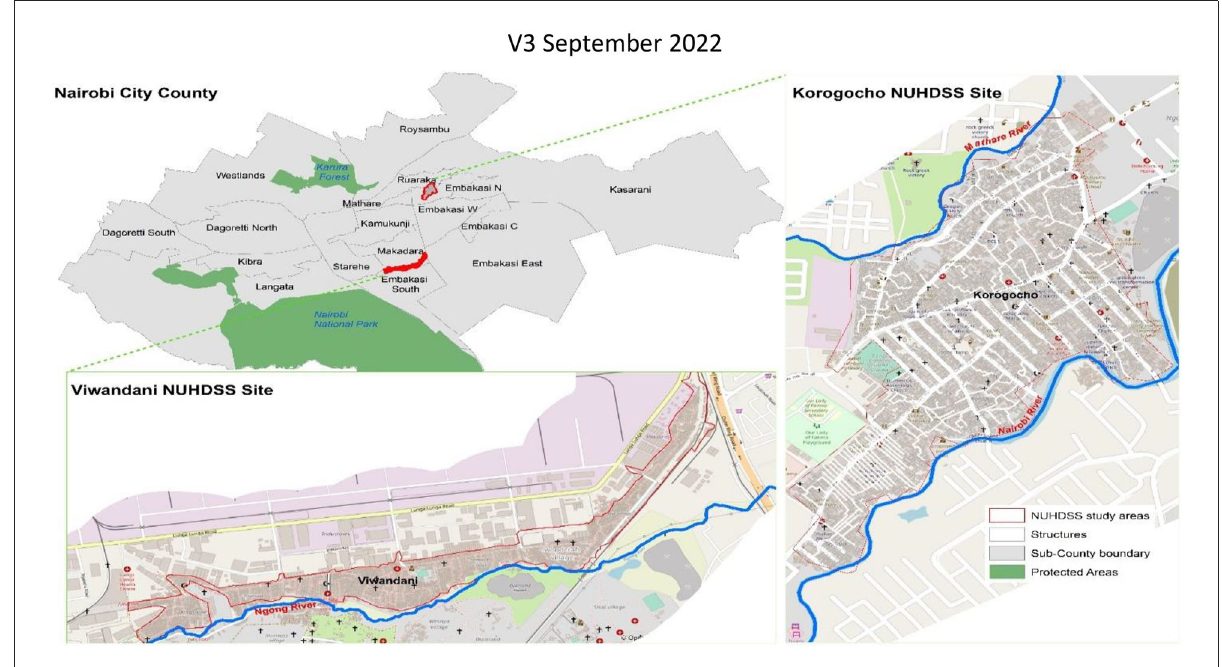
FIGURE1 Study sites (Source, authors,